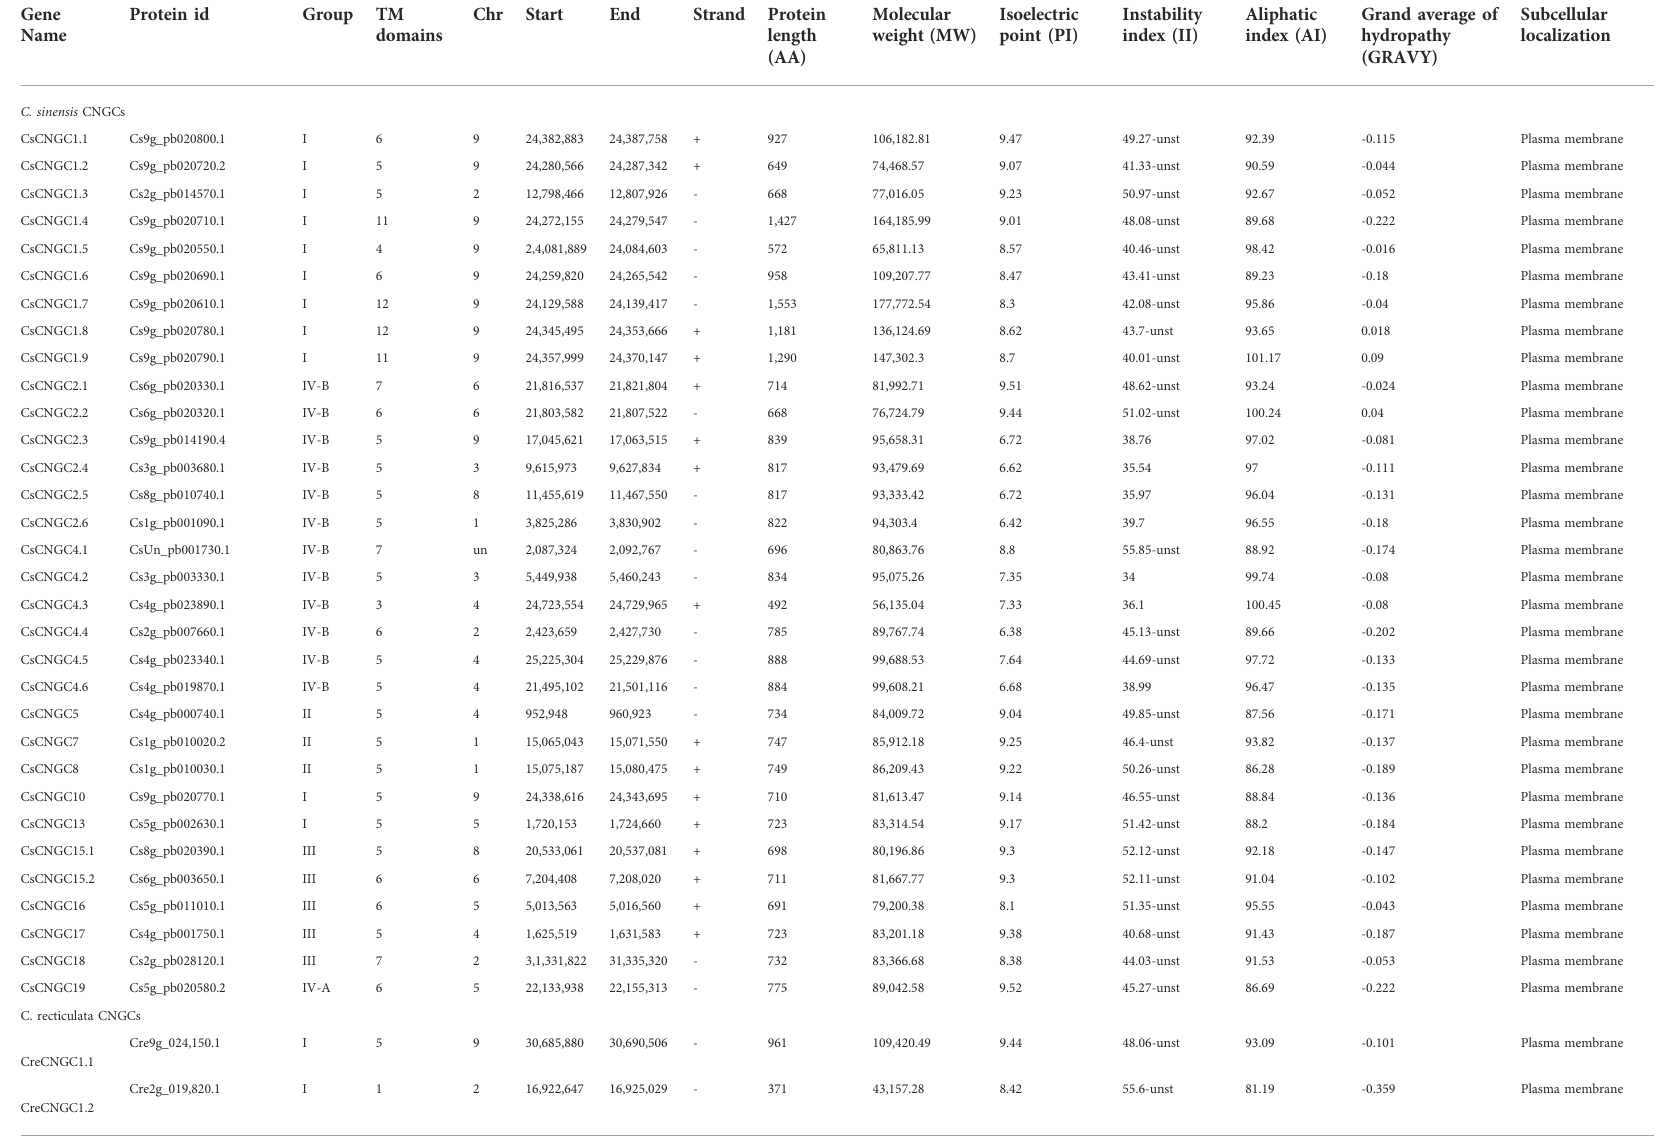
TABLE 2 Physiochemical properties of Citrus